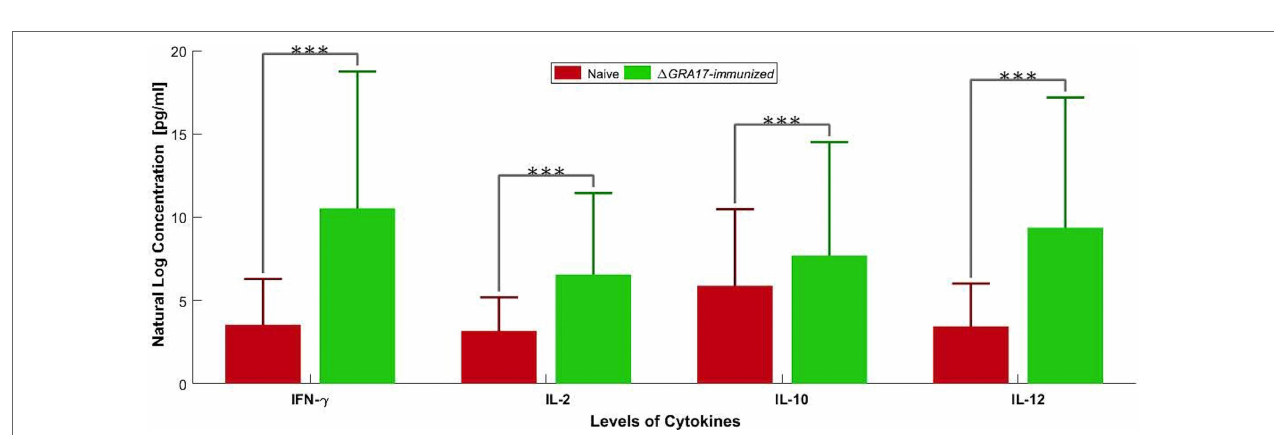
FigUre 5 | Levels of Th1 [IFN- γ , interleukin-2 (IL-2), and IL-12] and Th2 (IL-10) cytokines produced by spleen cells of Δ GRA17 -immunized mice. Spleen cells from mice were obtained 70 days postimmunization and were stimulated in vitro with soluble Toxoplasma gondii tachyzoite antigen (10 µg/ml). Cell-free supernatants were harvested and evaluated for IL-2, IL-10, IL-12, and INF- γ using ELISA. Significance compared with naïve control mice: *** p < 0.001.